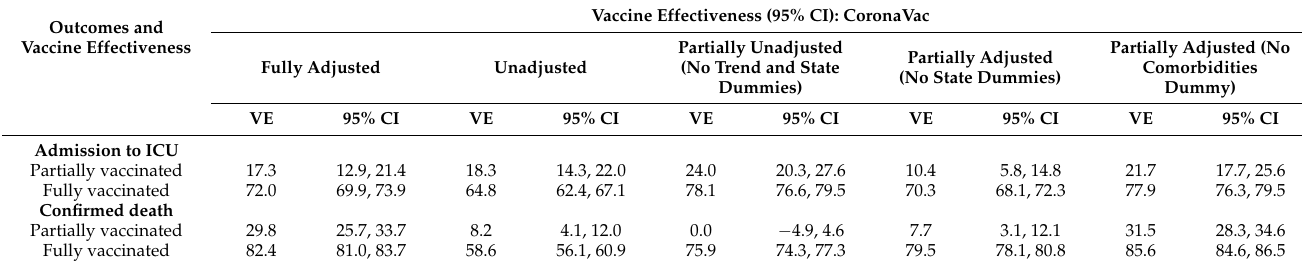
Table A5. Fully adjusted, partially adjusted, and unadjusted vaccine effectiveness in preventing admission to ICU and deaths among COVID-19 cases, according to vaccination status for CoronaVac. Outcomes and Vaccine